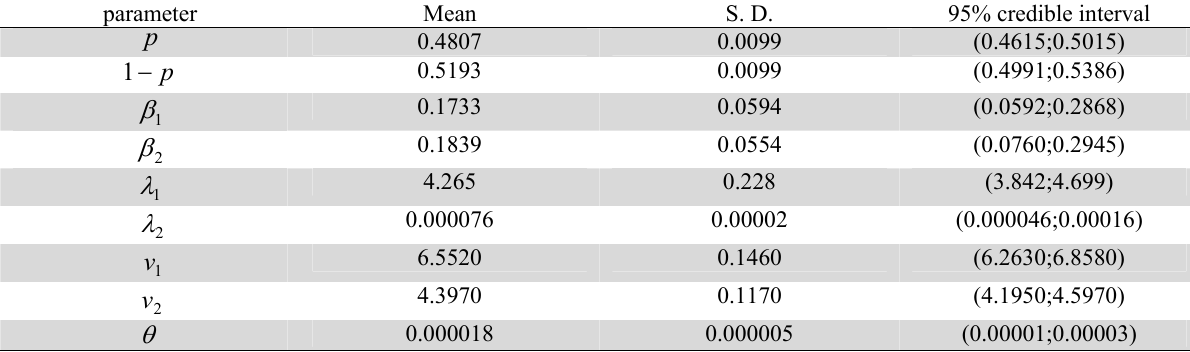
Posterior summaries (“model